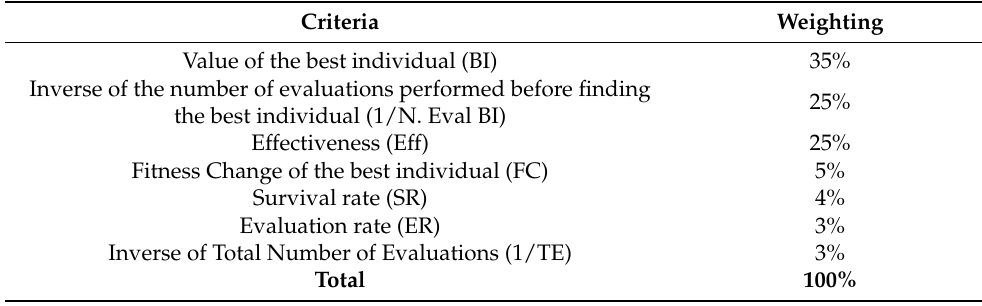
Figure 19. Example of the case analysis identification tag. Table 8. Weighted evaluation